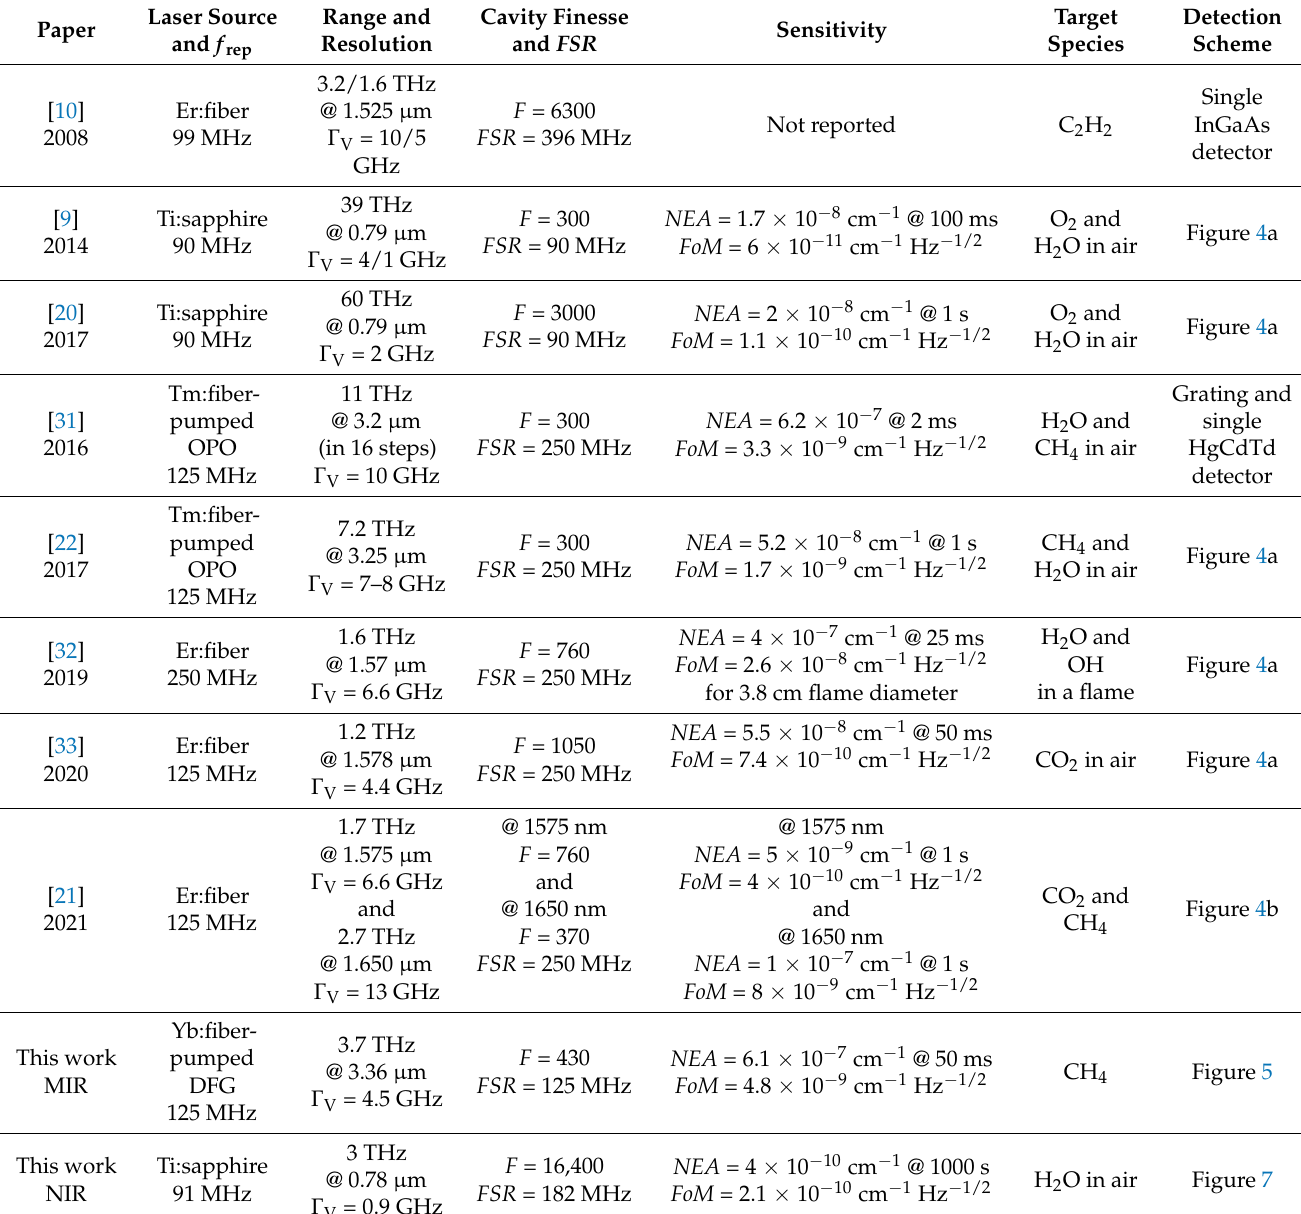
Table 2. Summary of continuous-filtering Vernier spectroscopy demonstrations. See text for